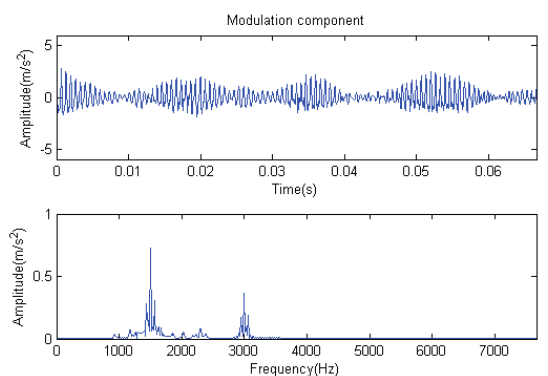
Figure 29. Modulation